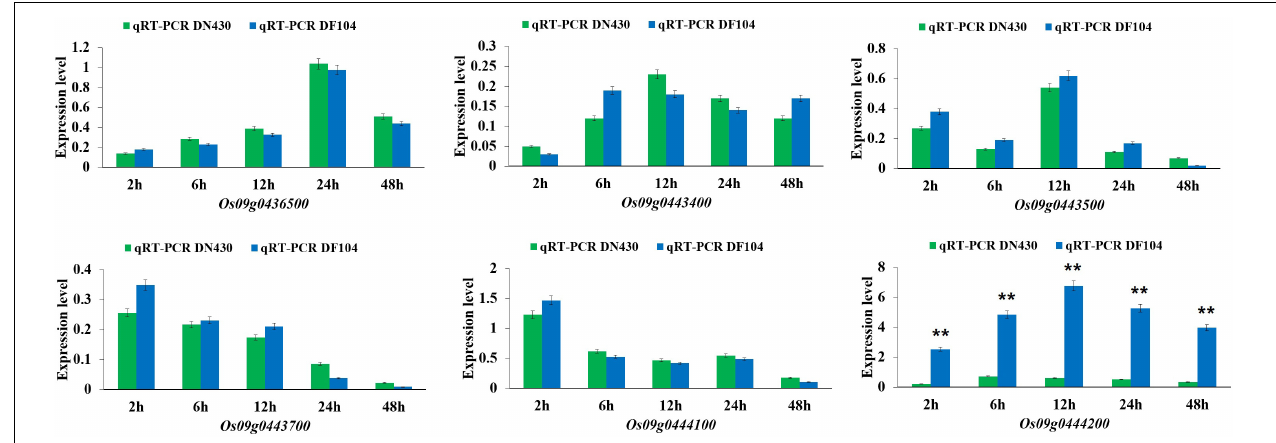
FIGURE 4 | Expression levels of the six candidate genes in DN430 and DF104 after cold stress measured by qRT-PCR. The results were statistically analyzed using Student’s t -test (** P < 0.01).